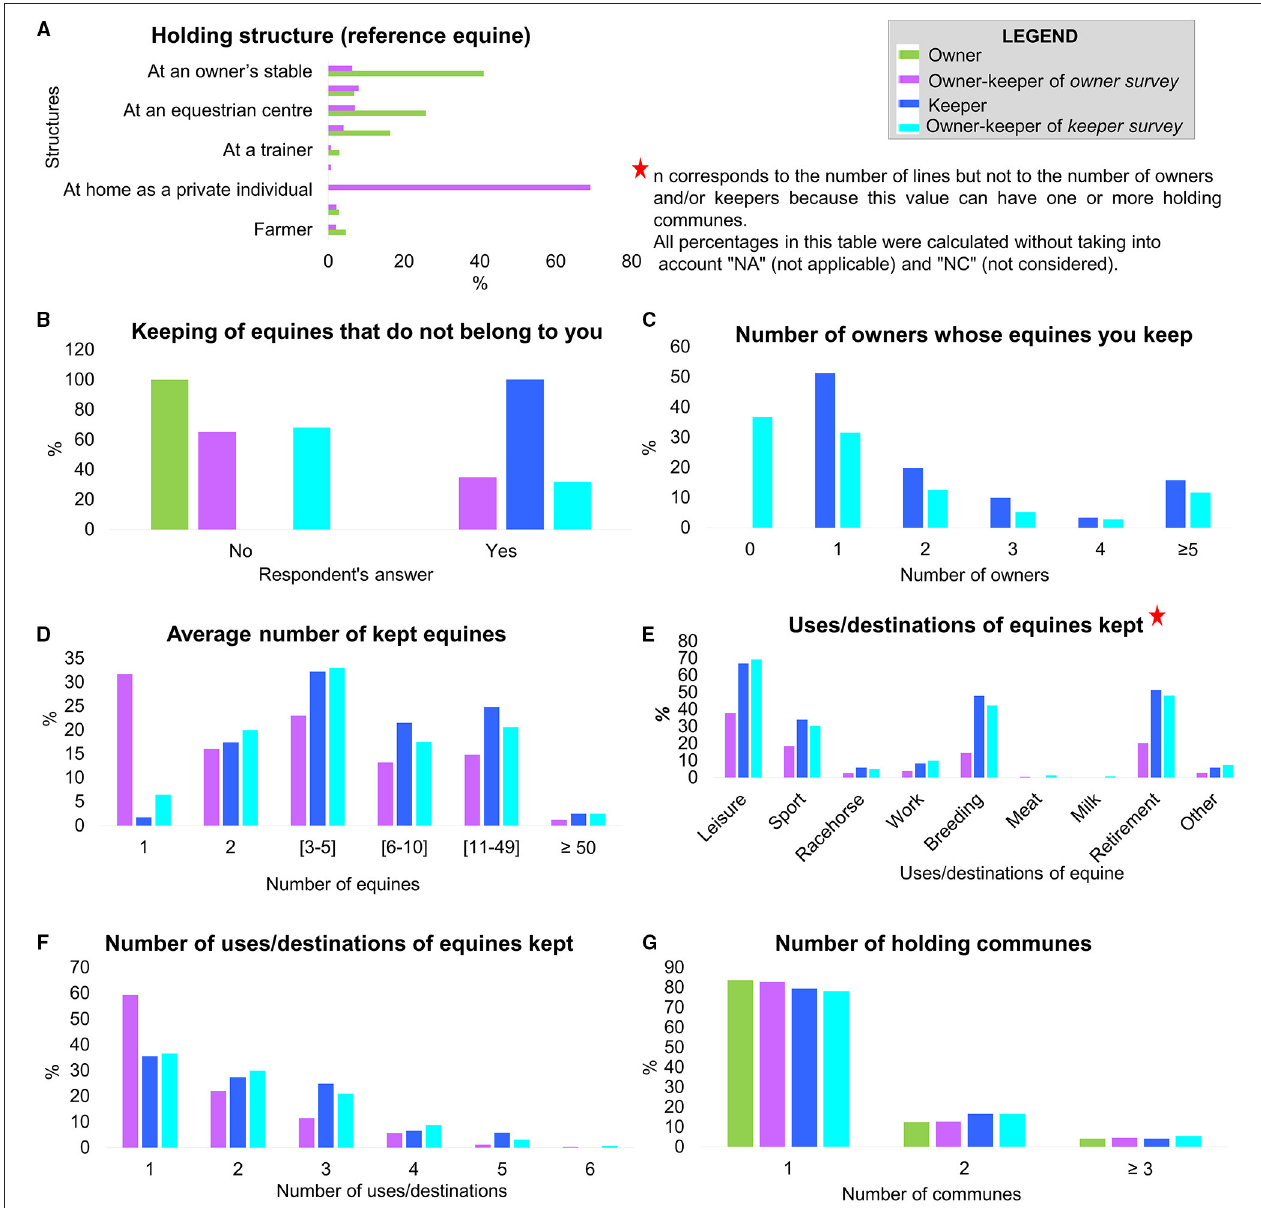
FIGURE 2 | Detailed results of repartition the different keeping habits: repartition (percentage) per survey and type of respondent (owner, owner–keeper, and keeper).